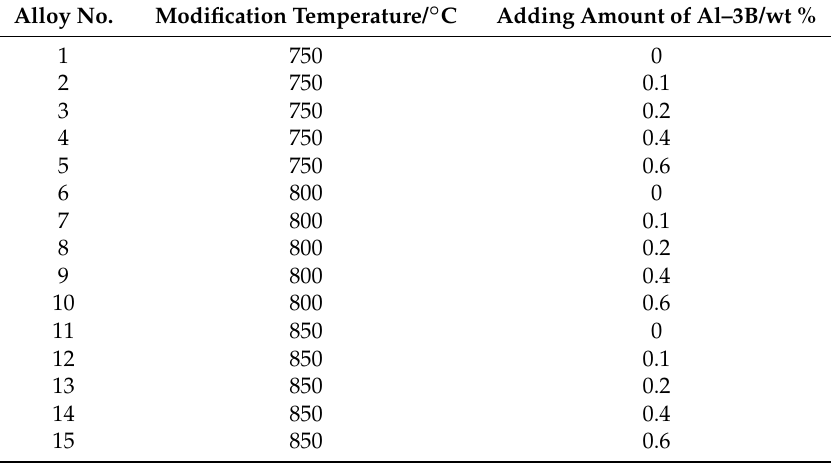
Table 1. Modification temperature of the Al–18Si alloy and the added amount of Al–3B. Alloy